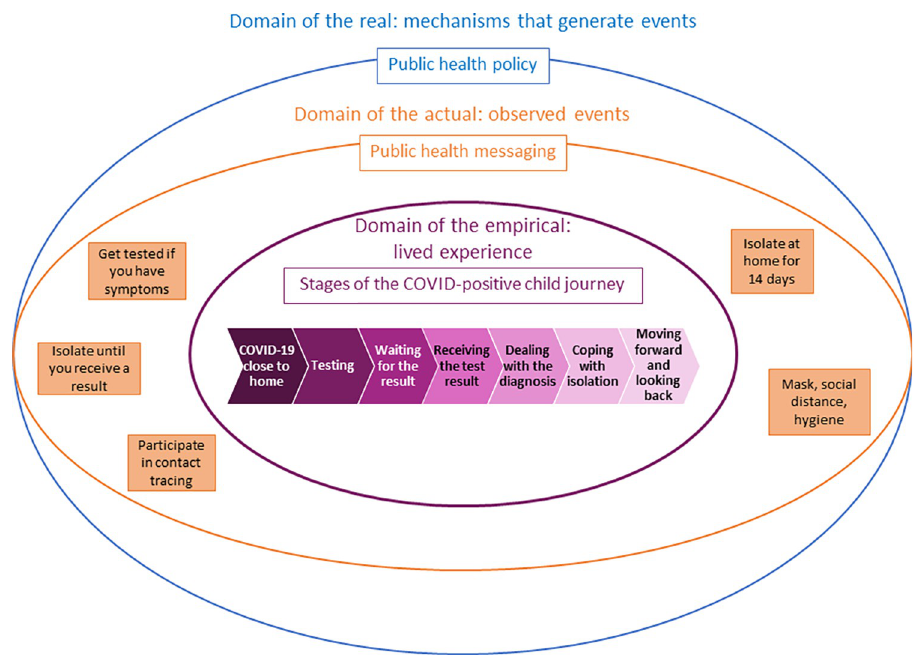
Fig 2. Critical realist matrix illustrating relationship between public health policy and messaging and the lived experience of families with a COVID-positive child.